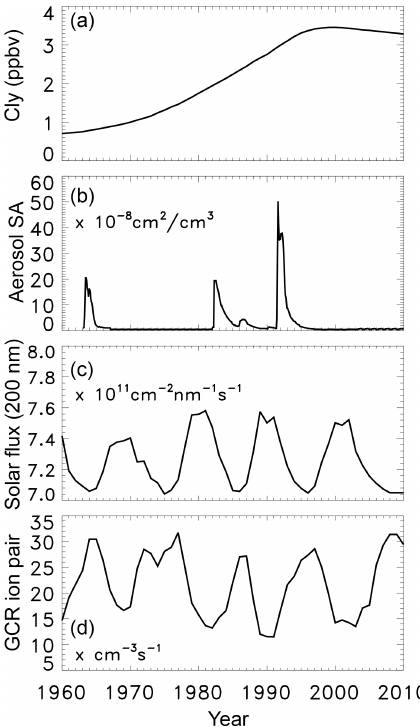
Figure 10. Forcing used in the GSFC 2-D model over the 1960– 2010 time period. These include: (a) background total chlo- rine (Cl y , in ppbv); (b) aerosol surface area (SA) at 50hPa and the Equator in 10 − 8 cm 2 cm − 3 ; (c) solar flux at 200nm in 10 11 cm − 2 nm − 1 s − 1 ; and (d) GCR ion pair production at 200hPa and 90 ◦ S in cm − 3 s − 1 .